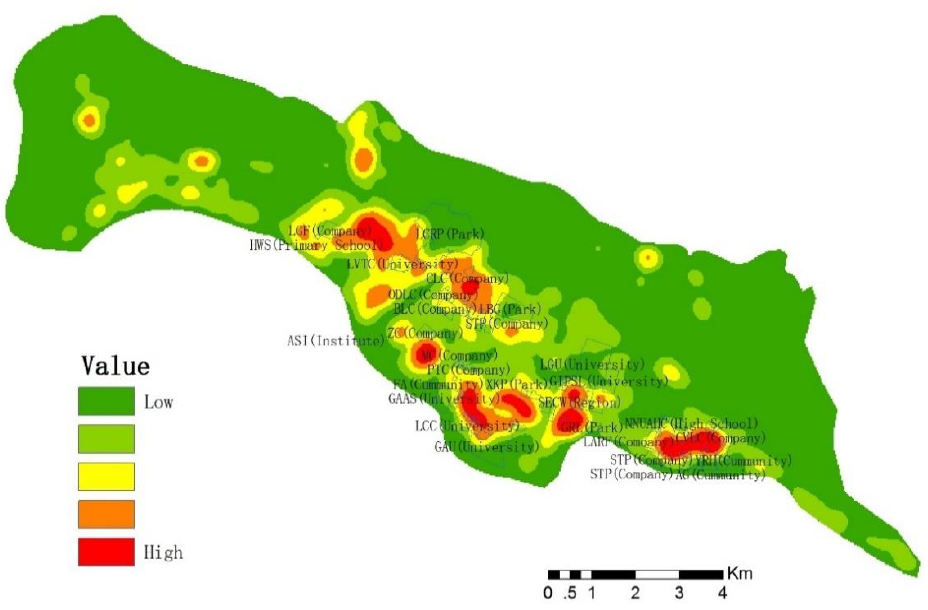
Figure. 5 Distribution of kernel density at the center of color steel buildings